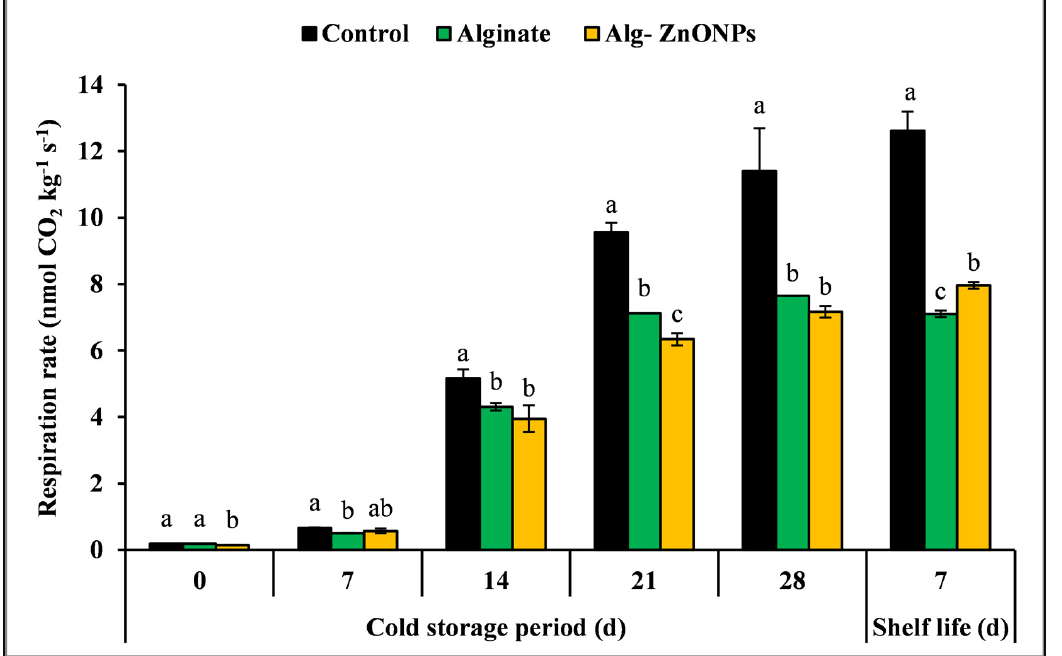
Figure 7. Effect of Alg–ZnO NPs on respiration rate of “Kiett” mango fruits during cold storage and shelf life; vertical bars represent the standard error (SE). Bars marked with the same letter in each sampling date are not significantly different with 95% confidence according to Duncan’s multiple range test.